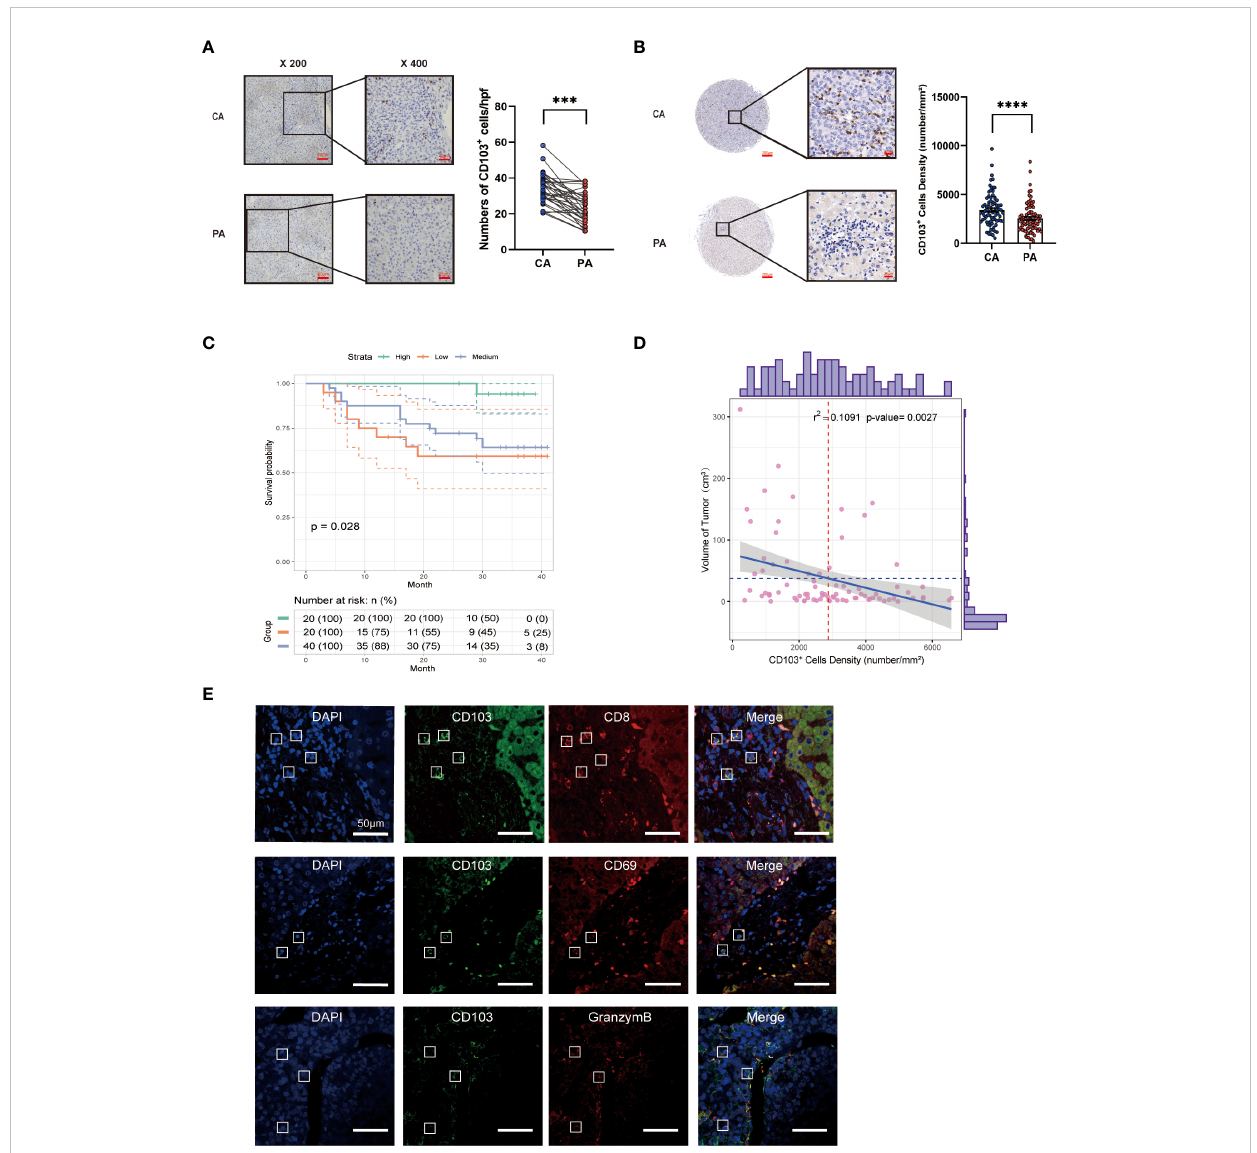
FIGURE 1 Hepatic CD69 + CD103 + CD8 + T-cell number is increased in HCC and is correlated with good prognosis. (A) Representative IHC staining of CD103 (inverted microscope, 200×, 400×) in CA and PA. Quanti fi cation of CD103 in the HCC patients from Cohort 1 (n = 35, A paired t -test). (B) Representative IHC staining of CD103 (inverted microscope, 200×, 400×) in TMA. Quanti fi cation of CD103 in the HCC patients from Cohort 2 (n = 80, A paired t -test). (C) Kaplan – Meier curves for the overall survival of the Cohort 2 groups with high, medium, and low CD103 expression, according to tri-sectional quantiles, showed that the patients with high CD103 expression had better prognostic outcomes than those with low CD103 expression (n = 80, log-rank test , P = 0.028). (D) Correlation between CD103 + cell density and tumor volume (n = 80, Spearman r 2 = 0.1246, P = 0.001321) (E) Representative confocal assay of CD103 with CD69, CD8, and GZMB (400×) in the liver tissues of HCC patients from Cohort 1 (n = 8). (A – E) Bars represent mean ± SEM. CA, carcinoma tissue; GZMB, granzyme B; HCC, hepatocellular carcinoma; IHC, immunohistochemistry; PA, paracancerous tissue; TMA, tumor microarray. ***P< 0.001, ****P<